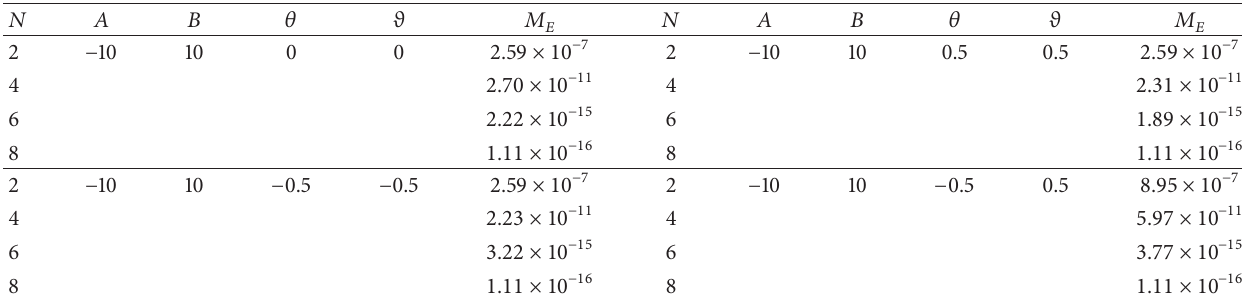
Table 1: Maximum absolute errors with various choices of 𝑁, 𝜃 , and 𝜗 with 𝜏 = 0.5 and 𝜆 1 = 0.01 for Example 2.